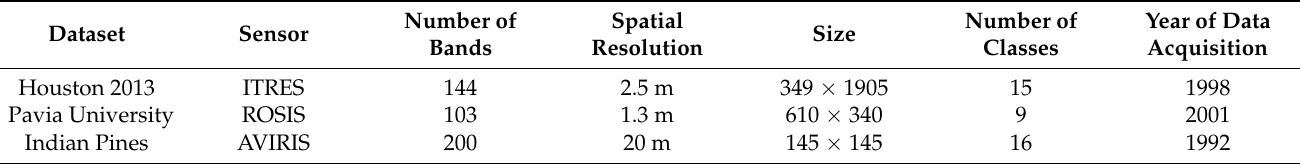
Table 2. Basic information of three main hyperspectral